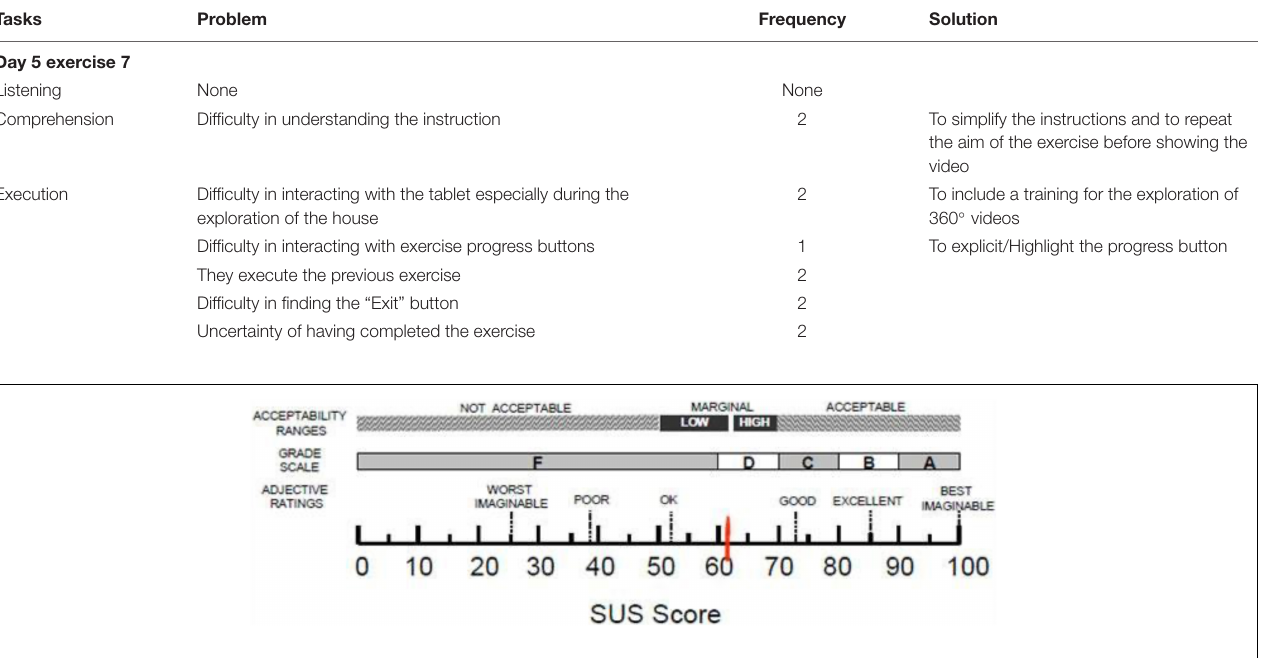
FIGURE 3 | Results of the SUS scale. TABLE 3 | Results of usability